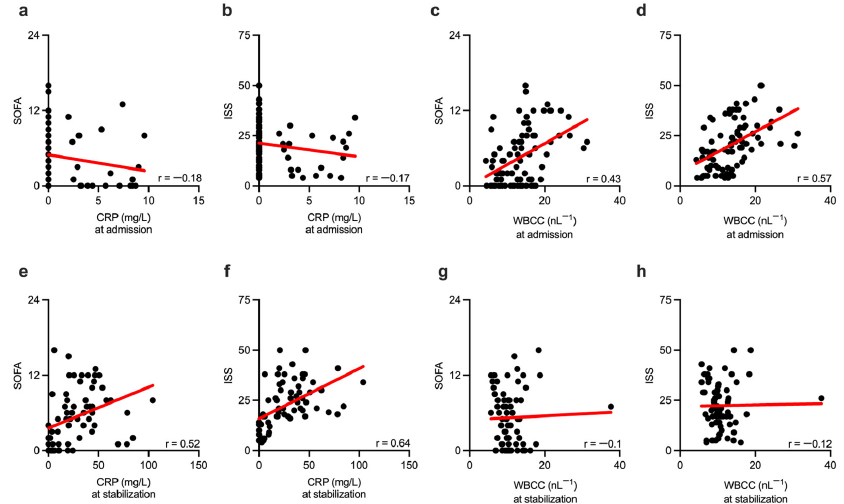
Figure 4. Correlation between measurement time and disease severity scores with conventional inflammatory biomarkers. CRP shows no correlation with the disease severity score SOFA. ( a ) nor with injury severity score ISS ( b ) when measured at the hospital admission. WBCC strongly correlates with SOFA ( c ) and ISS ( d ) at the same time point. Measurements obtained during the stabilization phase reveal a strong correlation between CRP and SOFA ( e ) as well as ISS ( f ) scores. WBCC showed no correlation with the disease severity scores SOFA ( g ) nor with ISS ( h ) at this time point. SOFA—Sequential Organ Failure Assessment; ISS—Injury Severity Score; CRP—C-reactive protein; WBCC—white blood cell count; r—Spearman correlation coefficient.